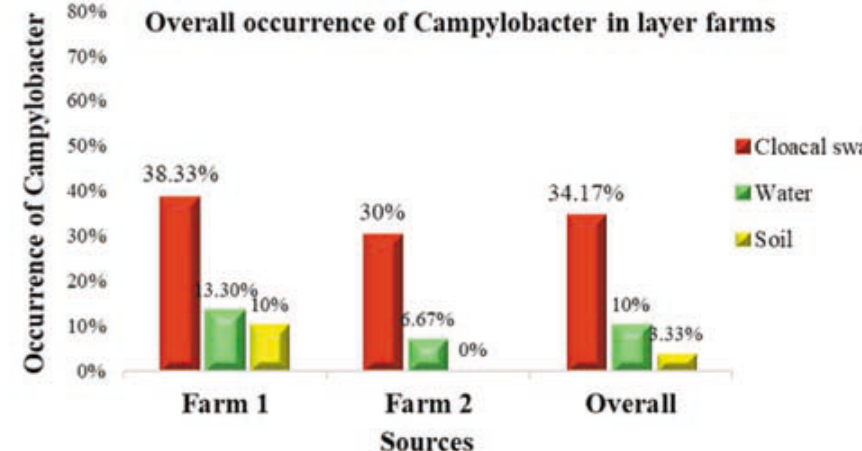
Fig. 2. Overall occurrence of Campylobacter in layer farms